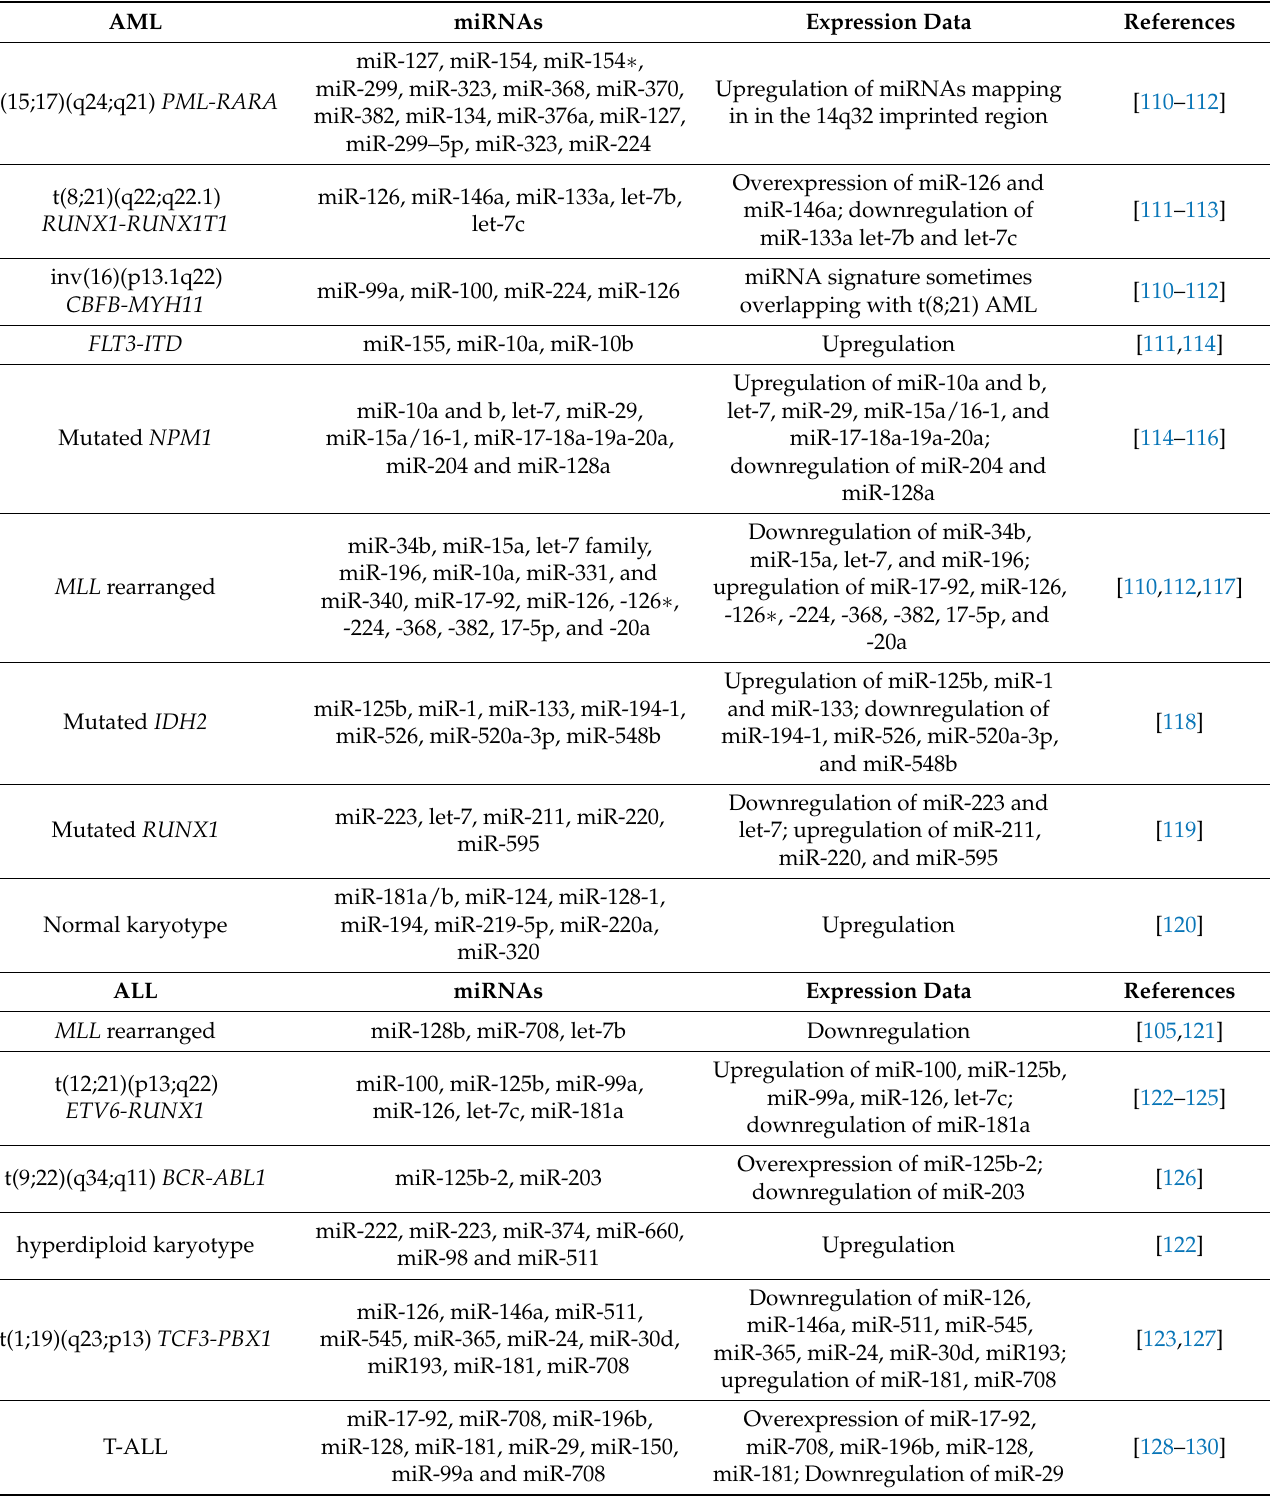
Table 1. miRNAs most frequently involved in acute leukemia